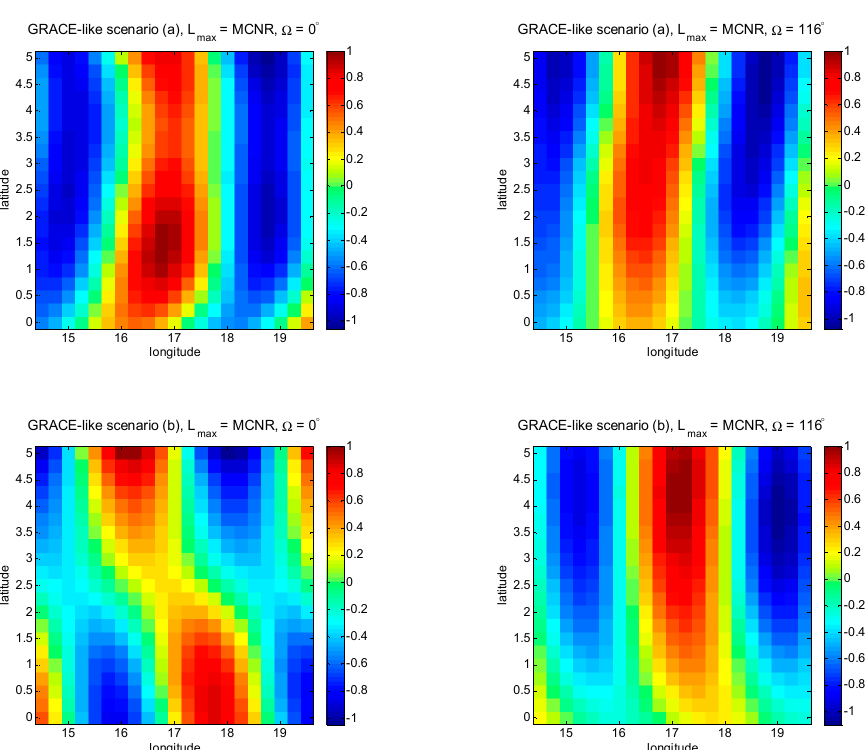
Figure 23. Spatial covariance of a selected point in West Africa (from Figures 19 and 20) for 6-day solution of the inline formation up to L max = CNR, for top : scenario (a), and bottom : scenario (b). Left is Ω = 0° and right is Ω = 116°.